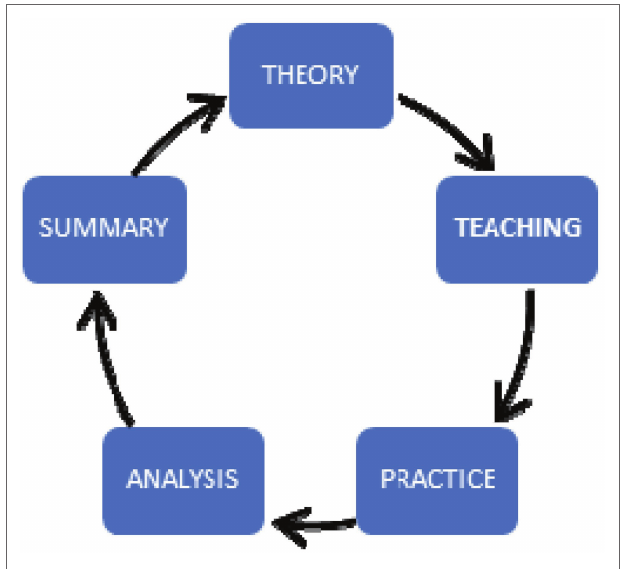
FIGURE 1 | Theoretical of research